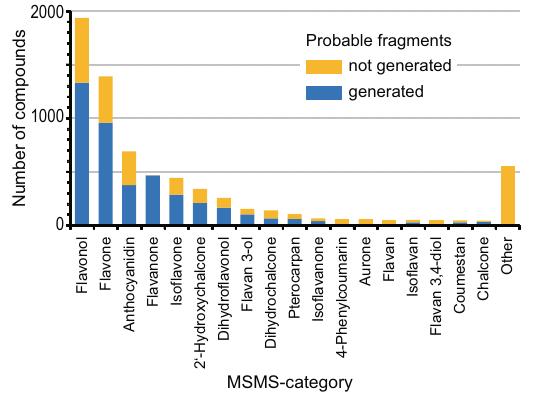
Figure 2. Coverage of flavonoids predictable by FlavonoidSearch. For the 6,867 known flavonoids, those with probable mass fragments generated in FsDatabase are shown in